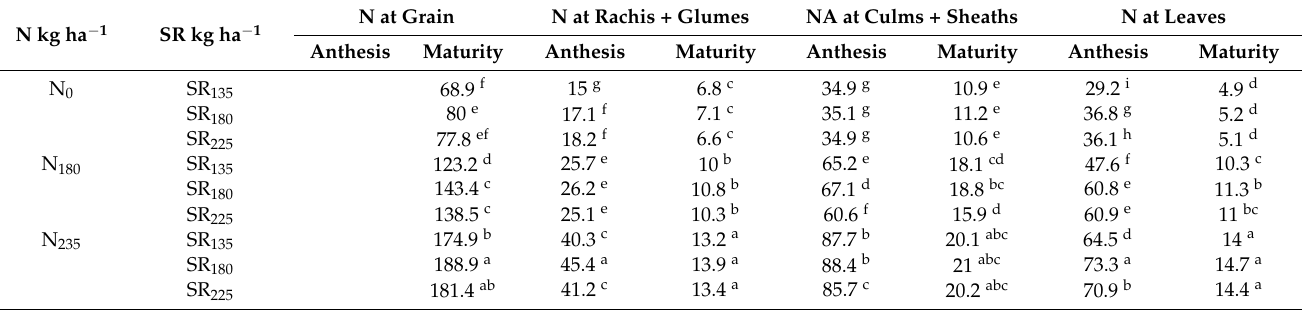
Table 5. Combination effects of N and SR on N partitioning during anthesis and maturity stages in